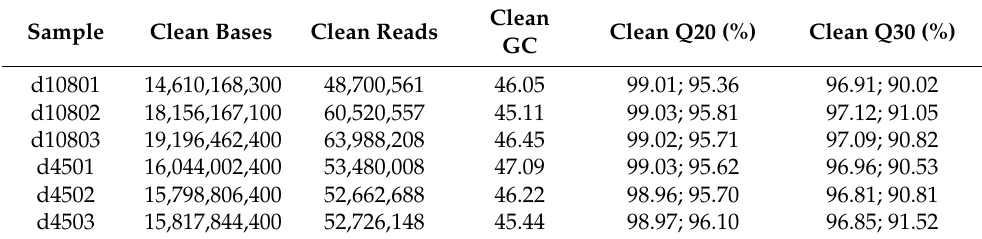
Table 1. Data quality control results of each